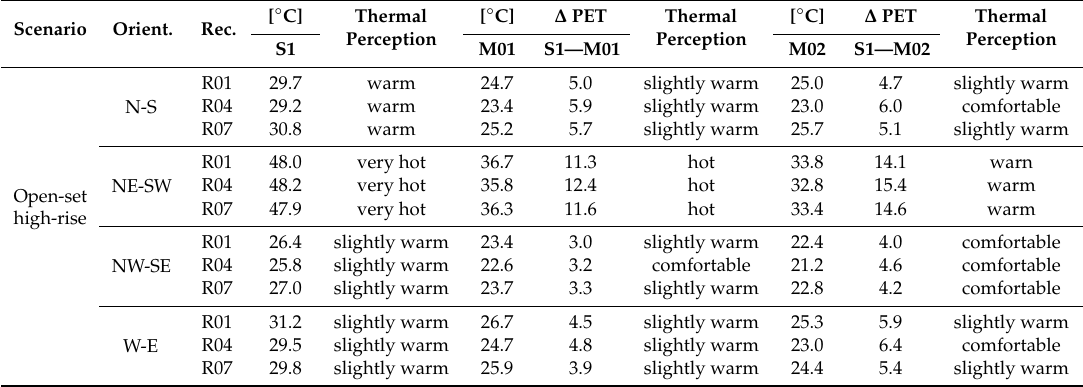
Table 16. PET Peak values for R01 (at the beginning of the urban canyon), R04 (in the middle) and R07 (at the end) in the open-set high-rise urban areas for the scenario S1, M01 and M02. Scenario Orient.